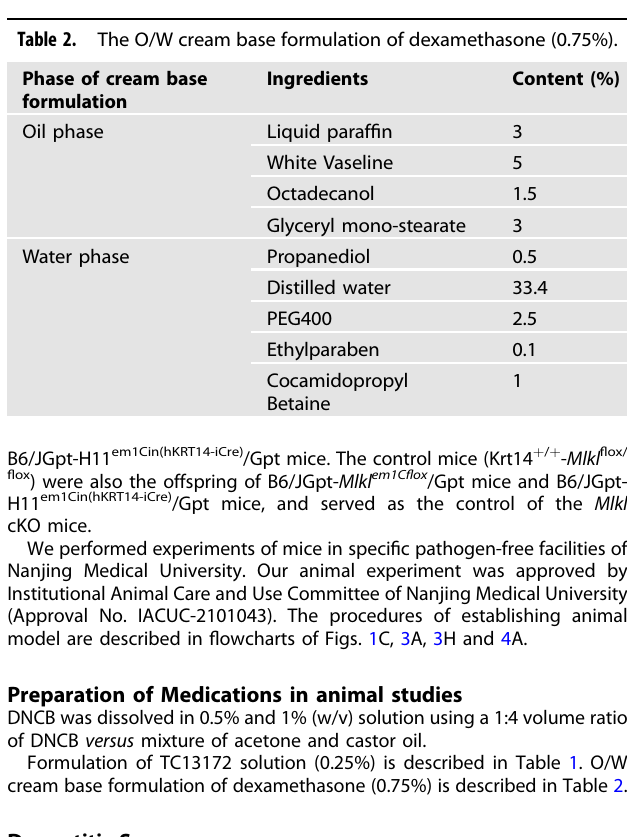
Fig. 6 MLKL-mediated HMGB1 secretion from keratinocyte facilitates DNCB-motivated CHS. A HMGB1 in the DNCB-motivated ears of Mlkl cKO mice and control mice were detected by immunohistochemistry assay. B The protein level of HMGB1 in epidermis was detected by western blotting. Statistical analysis of the interested protein was shown ( n = 3). C HMGB1 in the DNCB-motivated ears of wild type mice treated by intraperitoneal injection with TC13172 or solvent PBS were detected by immunohistochemistry assay. D The protein level of HMGB1 in epidermis was detected by western blotting. Statistical analysis of the interested protein was shown ( n = 3). E HMGB1 in DNCB- motivated ears of wild type mice topically treated by necrostatin-1 or vehicle were detected by immunohistochemistry assay. F The protein level of HMGB1 in epidermis was detected by western blotting. Statistical analysis of the interested protein was shown ( n = 3). G – I Mlkl cKO mice (Krt14 Cre/ + - Mlkl fl ox/ fl ox ) and control mice (Krt14 + / + - Mlkl fl ox/ fl ox ) were intradermal injected with rHMGB1 (right ear) and PBS (left ear), respectively. The skin appearance ( G ), histology feature ( H ) and in fi ltration of MPO, MMP-9 and NE ( I ) were shown. J The protein levels of HMGB1 in nucleus, cell plasma and supernatant were detected by western blotting in the MLKL knockdown HaCaT cells in the presence or absence of TNF- α and IFN- γ . Statistical analysis of the interested protein was shown ( n = 3). K HMGB1 secretion in supernatants of cultured HaCaT cells were determined by ELISA. Scale bar ( A , C , E ) represents 20 μ m. Scale bar ( H , I ) represents 200 μ m. ∗ p < 0.05.